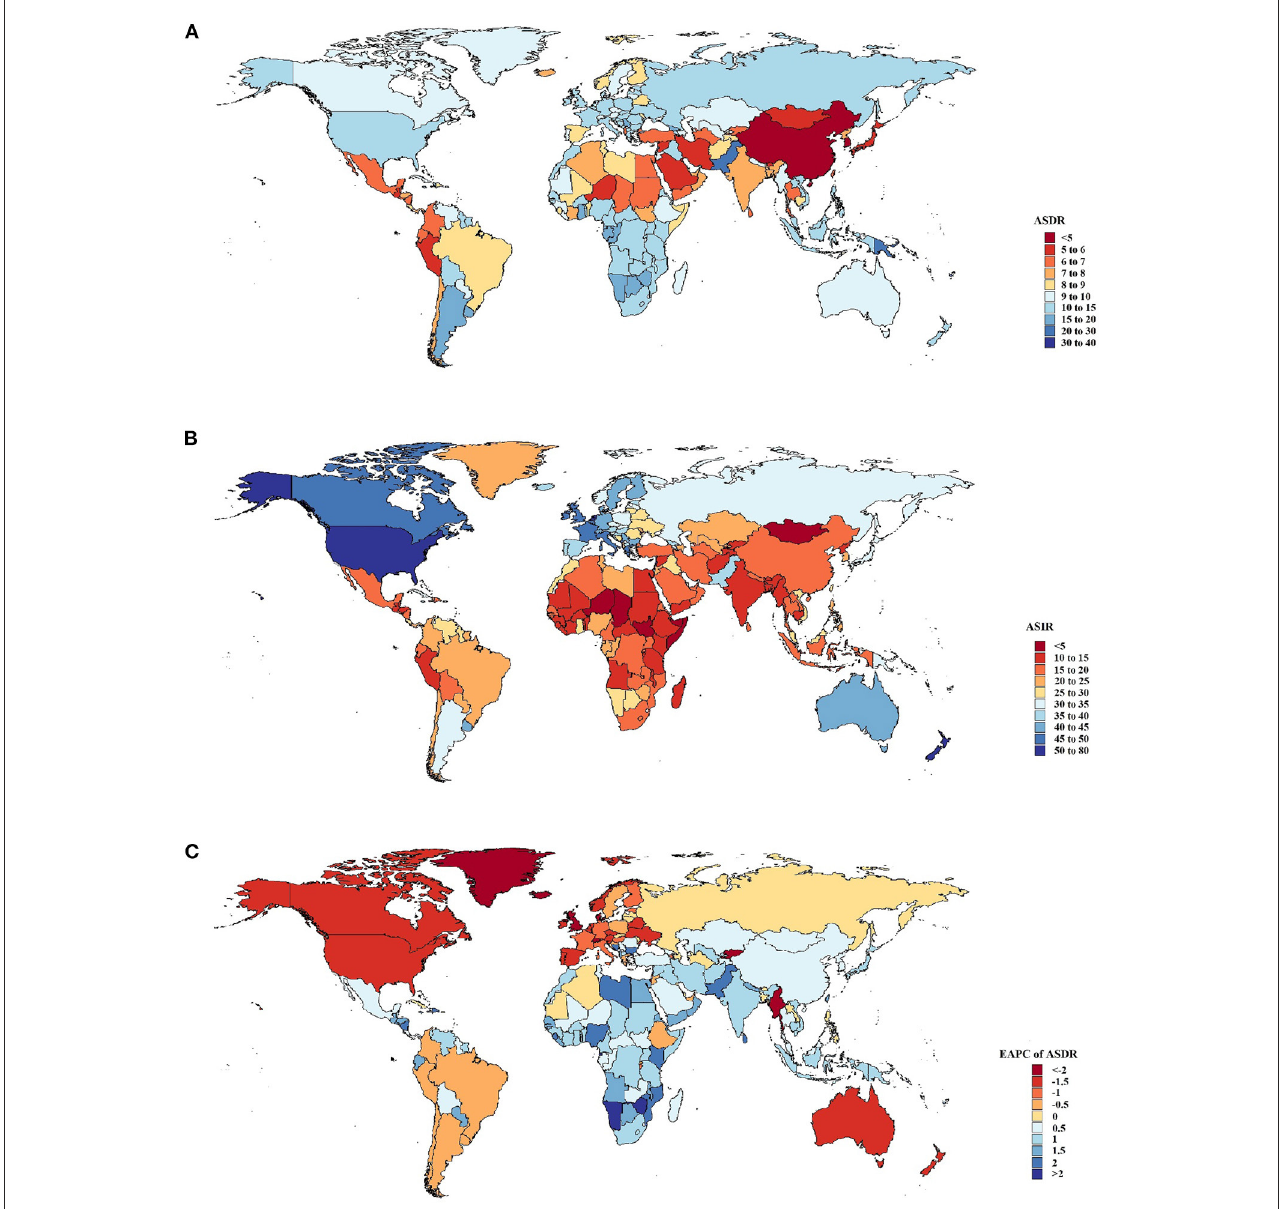
FIGURE1 Global death and incidence cases and death rates of breast cancer from 1990 to 2019. (A) Age-standardized death rates (ASDRs) in 204 countries and territories in 2019. (B) Age-standardized incidence rates (ASIRs) in 204 countries and territories in 2019. (C) Estimated annual percentage changes (EAPCs) in ASDRs in 204 countries and territories from 1990 to